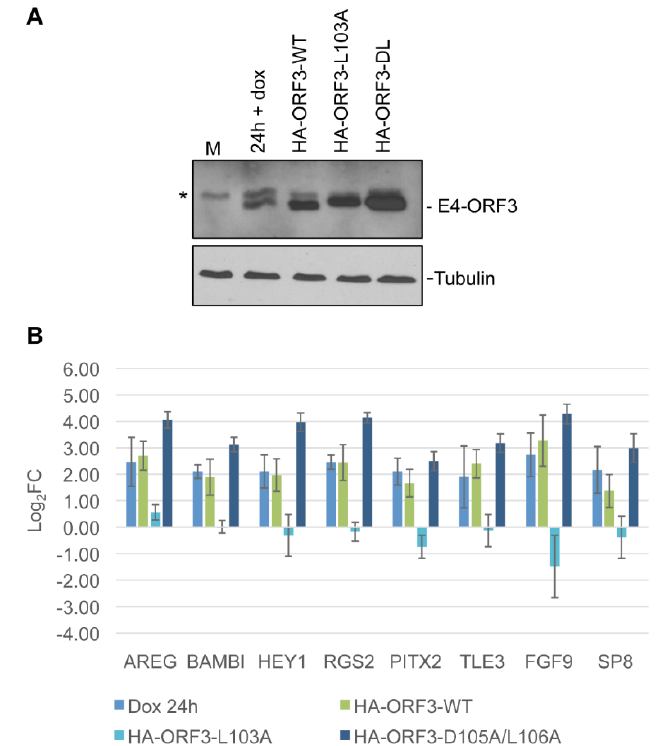
Figure 4. Nuclear track formation, but not sequestration of the MRN complex, is necessary for the up-regulation of select E4-ORF3 target genes. Cells were induced with doxycycline or infected with wild-type or mutant E4-ORF3-expressing Ad vectors to yield an equivalent amount of protein product. E4-ORF3 L103A folds properly but fails to form nuclear tracks. E4-ORF3 D105A/L106A forms tracks and relocalizes all known targets except the MRN complex. ( A ) Protein levels were verified by Western blot analysis. * Indicates a background band; ( B ) Cellular transcript levels were recorded by relative quantification RT-qPCR. Bars represent Log2 fold change in expression at 24hpi + E4-ORF3, relative to mock, normalized to GAPDH. Error bars = S.D., n = 3. Gene expression differences in the presence of HA-ORF3-WT vs . HA-ORF3-L103A are statistically significant ( p < 0.05) for every target except SP8 as determined by one-way ANOVA analysis with multiple